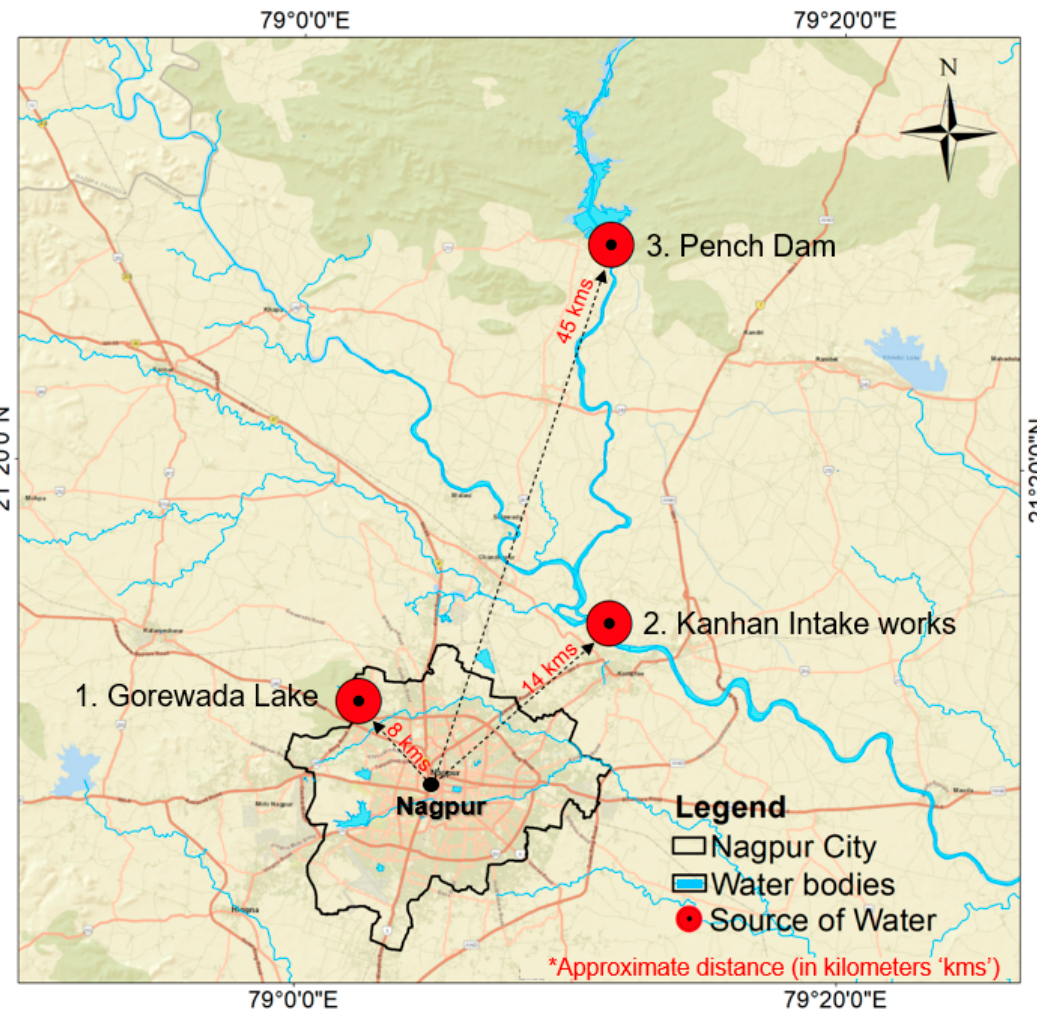
Figure 2. Location map of key surface-water sources for Nagpur City. Prepared by the authors; the background image was sourced from Esri, HERE, Gramin, USGS, Intermap, INCREMENT P, NR Can, Esri Japan, METI, Esri China (Hong Kong), Esri Korea (Thailand), NGCC, OpenStreetMap contributors, and the community.